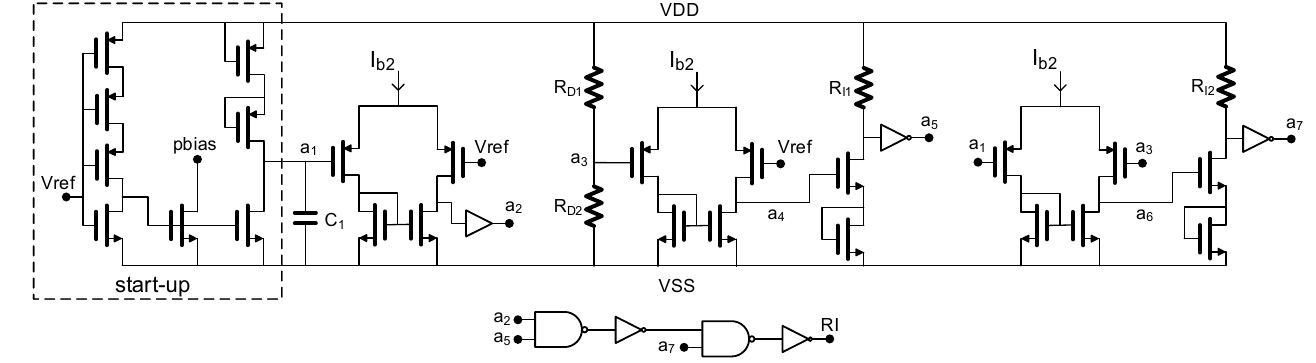
Figure 6. The RI circuit for BGR#1 in CMOS 65 nm technology and 1 V supply voltage.